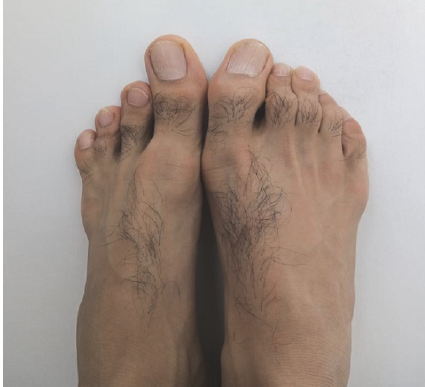
Figure 2: Clinical photograph of the patient with oligodactyly of the left